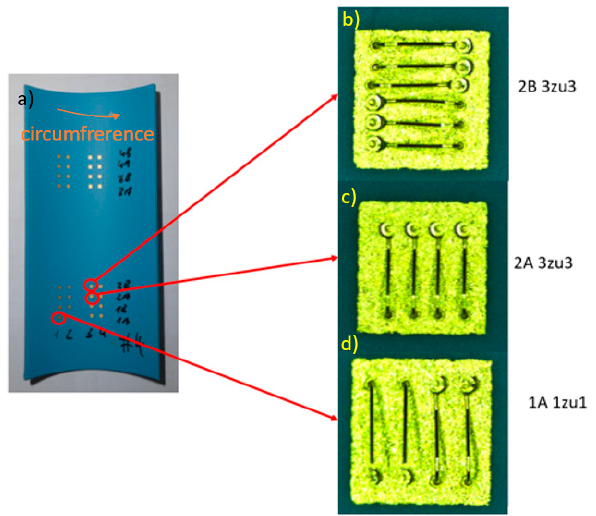
Figure 10. Bond connections on a concave substrate. ( a ) position of landing pads; ( b – d ) details of the obtained bond connections.